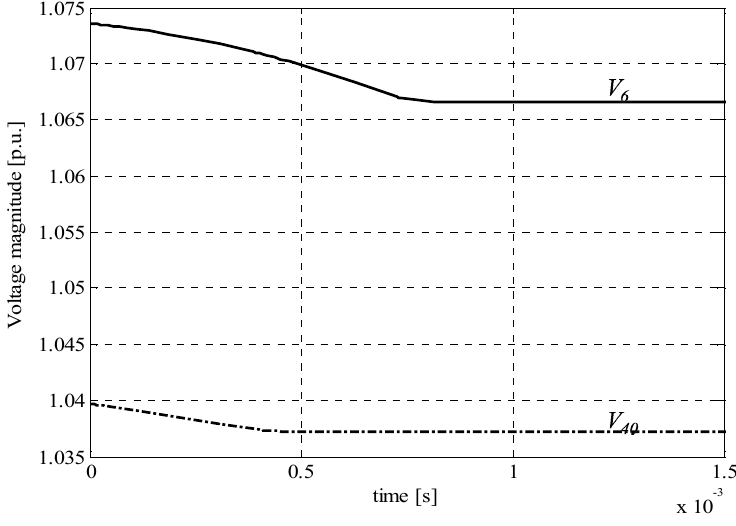
Figure 10. Time domain behavior of the voltage at the control bus.